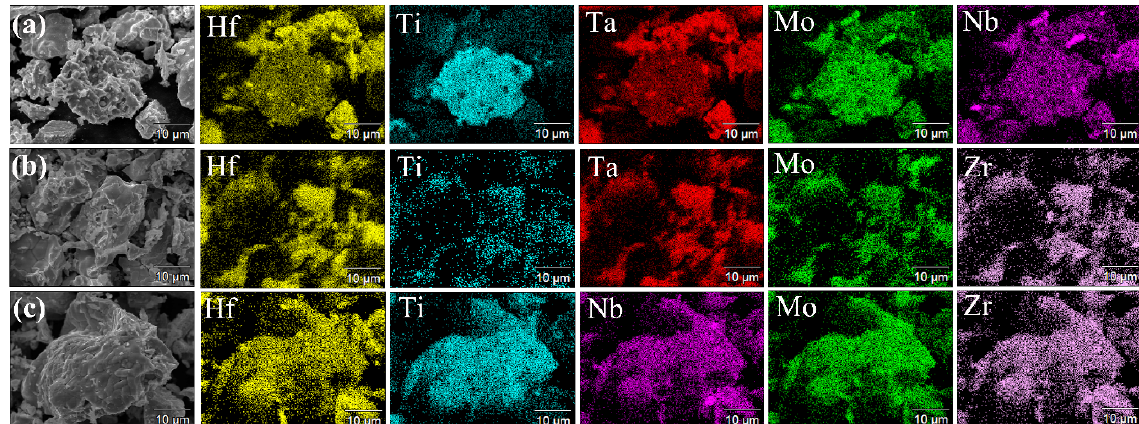
Figure 2. SEM micrographs and corresponding EDS elemental maps of ( a ) HEB_a, ( b ) HEB_b, and ( c ) HEB_c powders prepared by SHS.